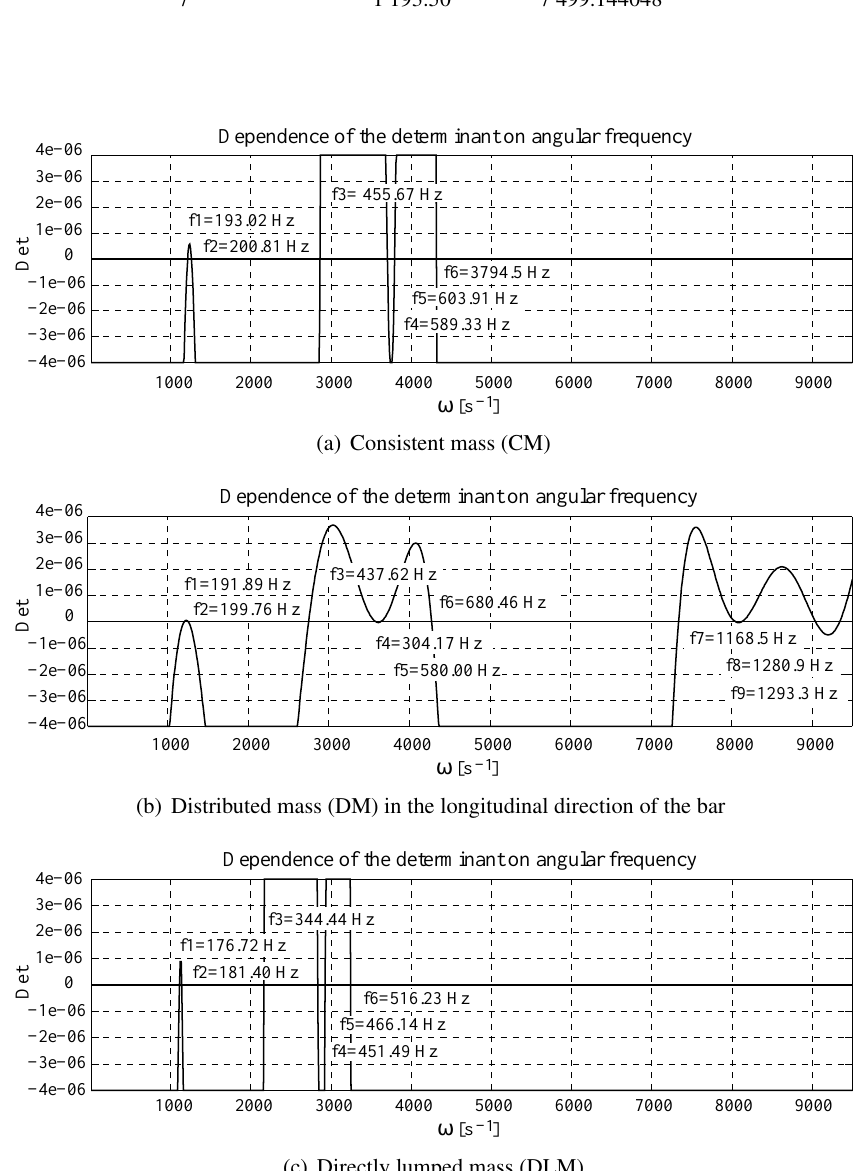
Fig. 13. Natural frequencies of the seven-bar